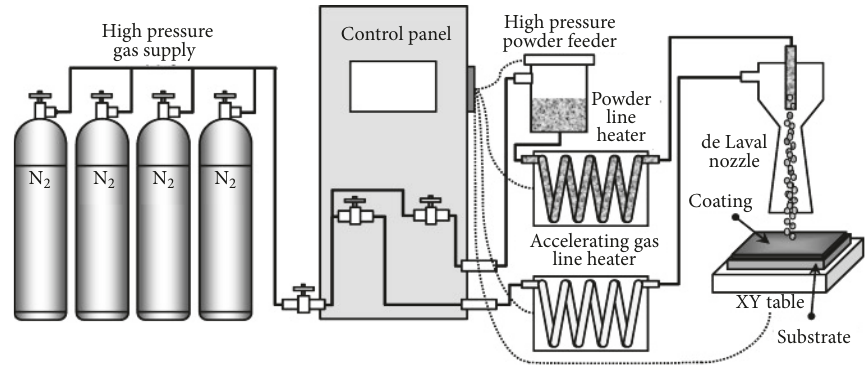
Figure 2: Principle of cold spray technique for preparation of nanocomposite [86].